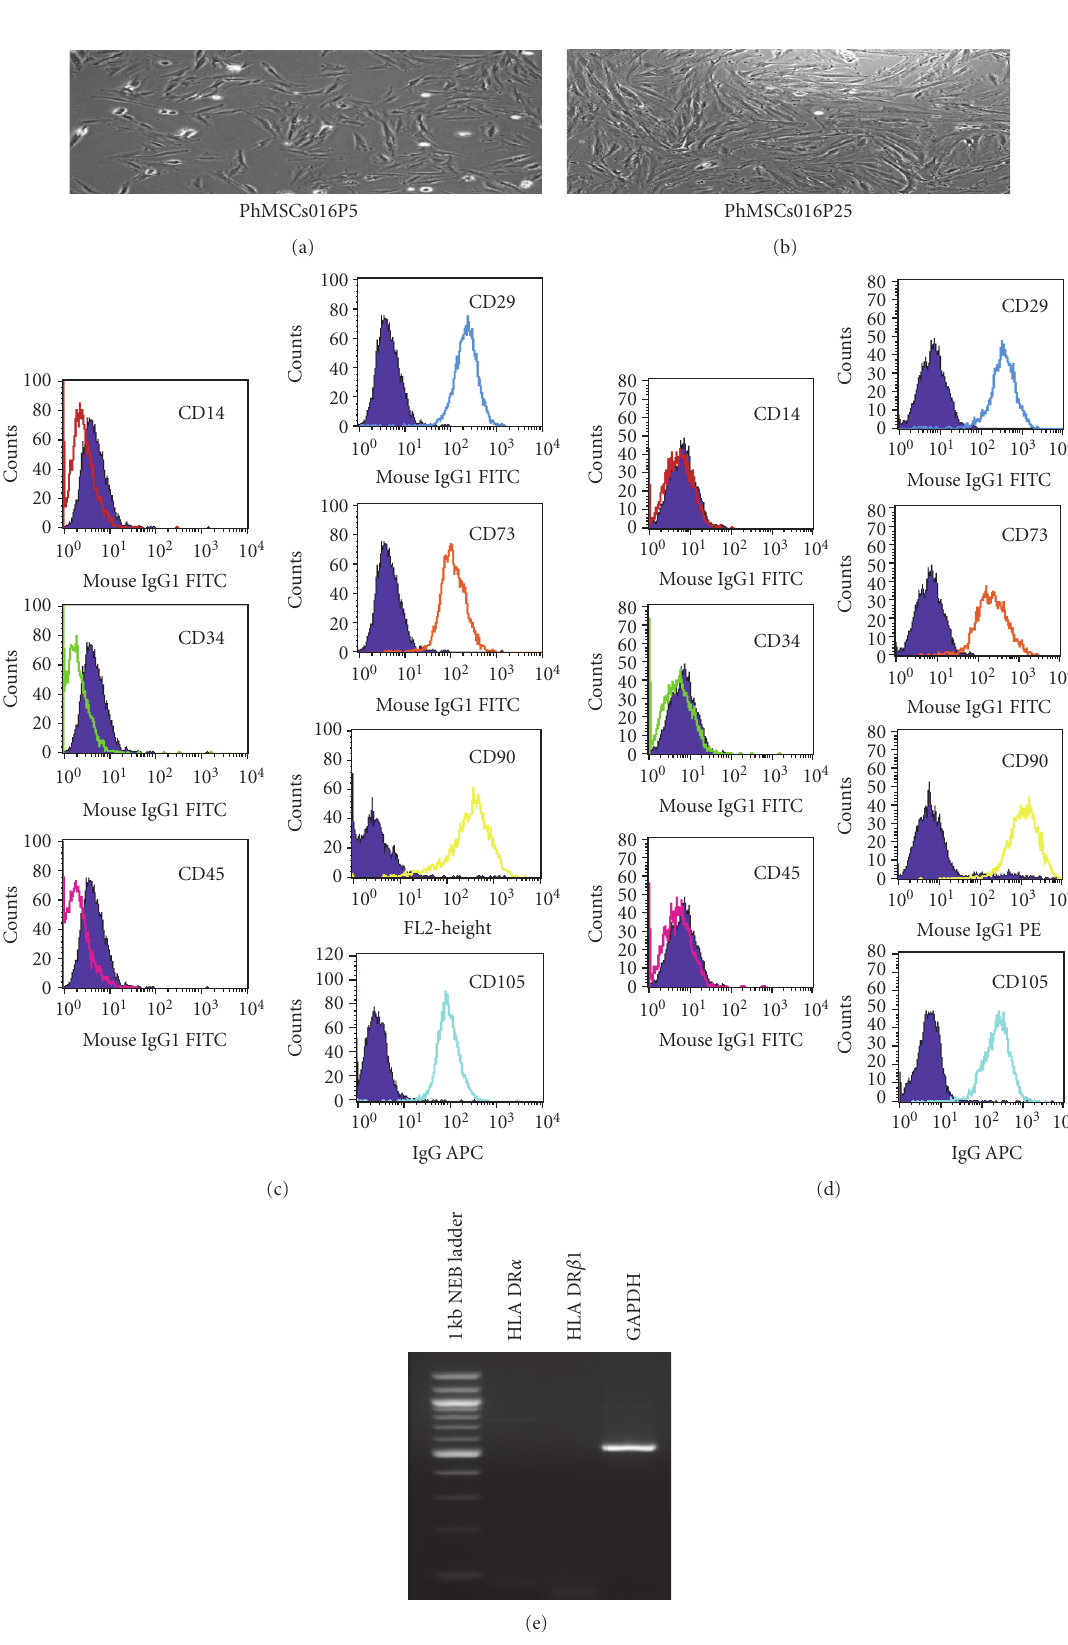
Figure 1: Morphology and characteristics of placental MSCs. (a) morphology of the placental MSCs at passage 5; (b) morphology of the placental MSCs at passage 25; (c) flowcytometric analysis of Placental MSCs at passage 5; (d) flowcytometric analysis of Placental MSCs at passage 25; (e) RT-PCR analysis of placental MSCs (PhMSCs 020P3) for MHC class II